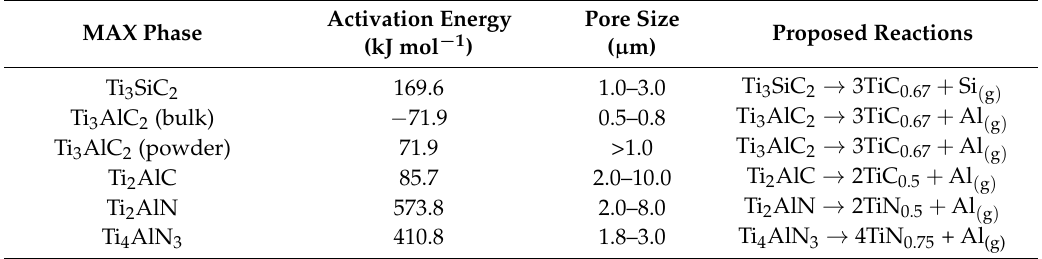
Table 1. Comparison of the kinetics of decomposition in six MAX-phase samples. Courtesy of AZom.com [10].